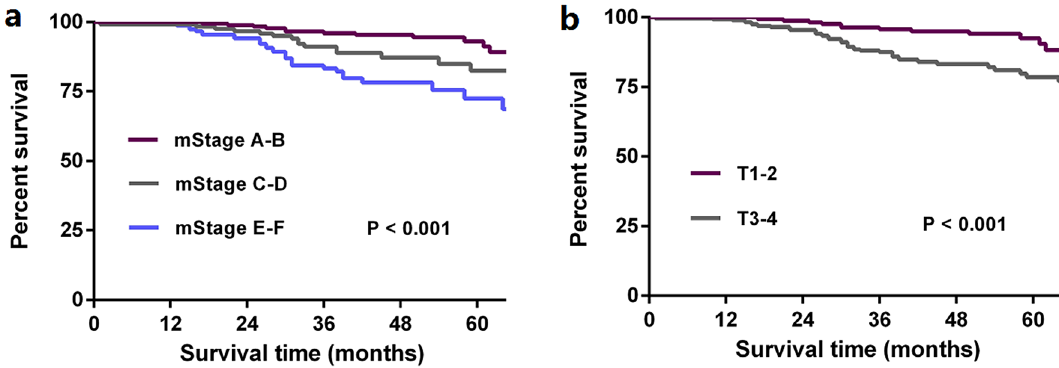
Figure 5. Kaplan–Meier curves stratified by mStage ( a ) and conventional TNM stage ( b ) in the validation cohort.